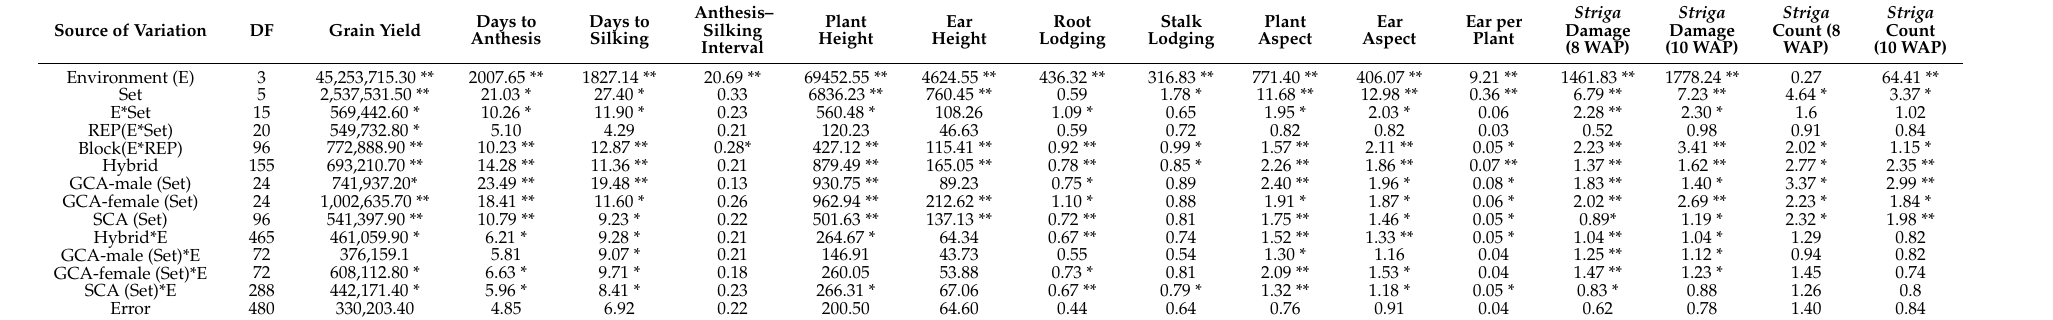
Table 2. Mean squares derived from a combined analysis of variance for grain yield and other phenotypic traits of the 150 single-cross hybrids tested under artificial Striga infestation conditions in Ghana and Nigeria in 2016 and 2017.